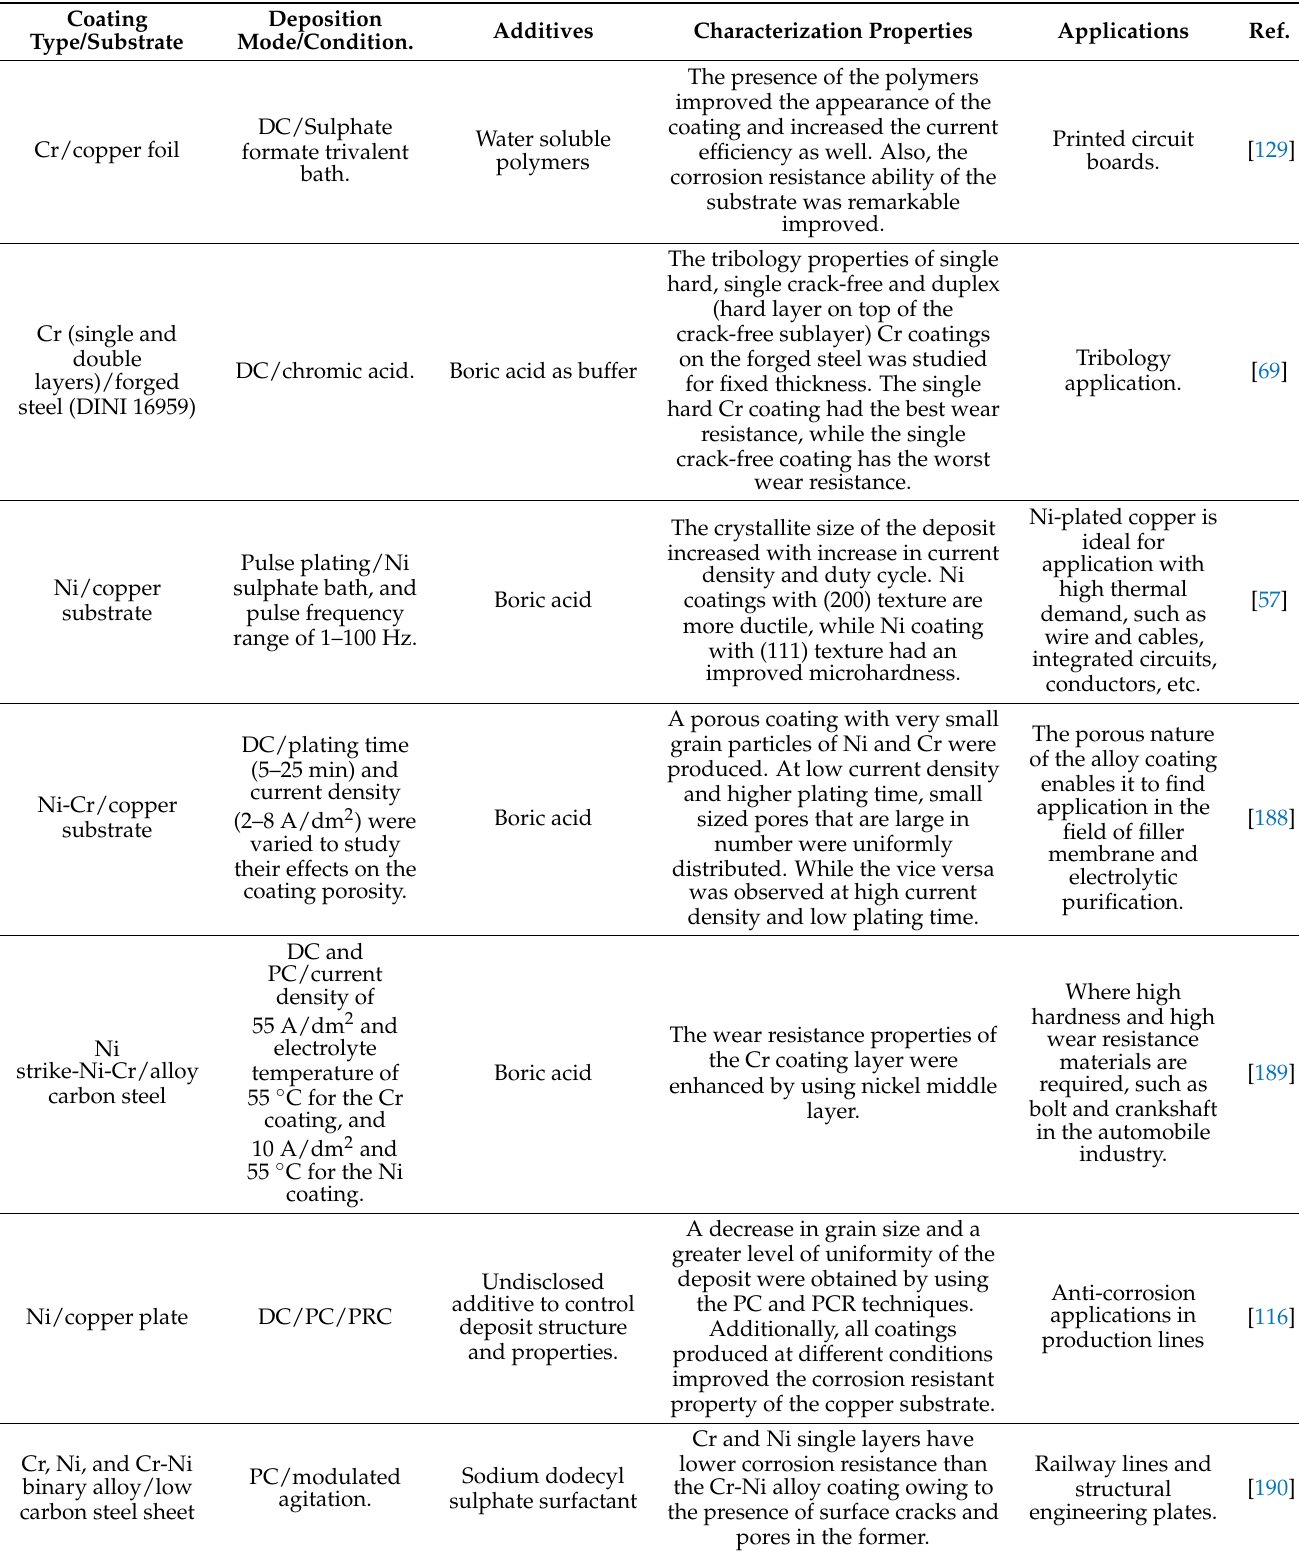
Table 2. A summary of previous studies showing the different applications of Ni, Cr, and their alloy